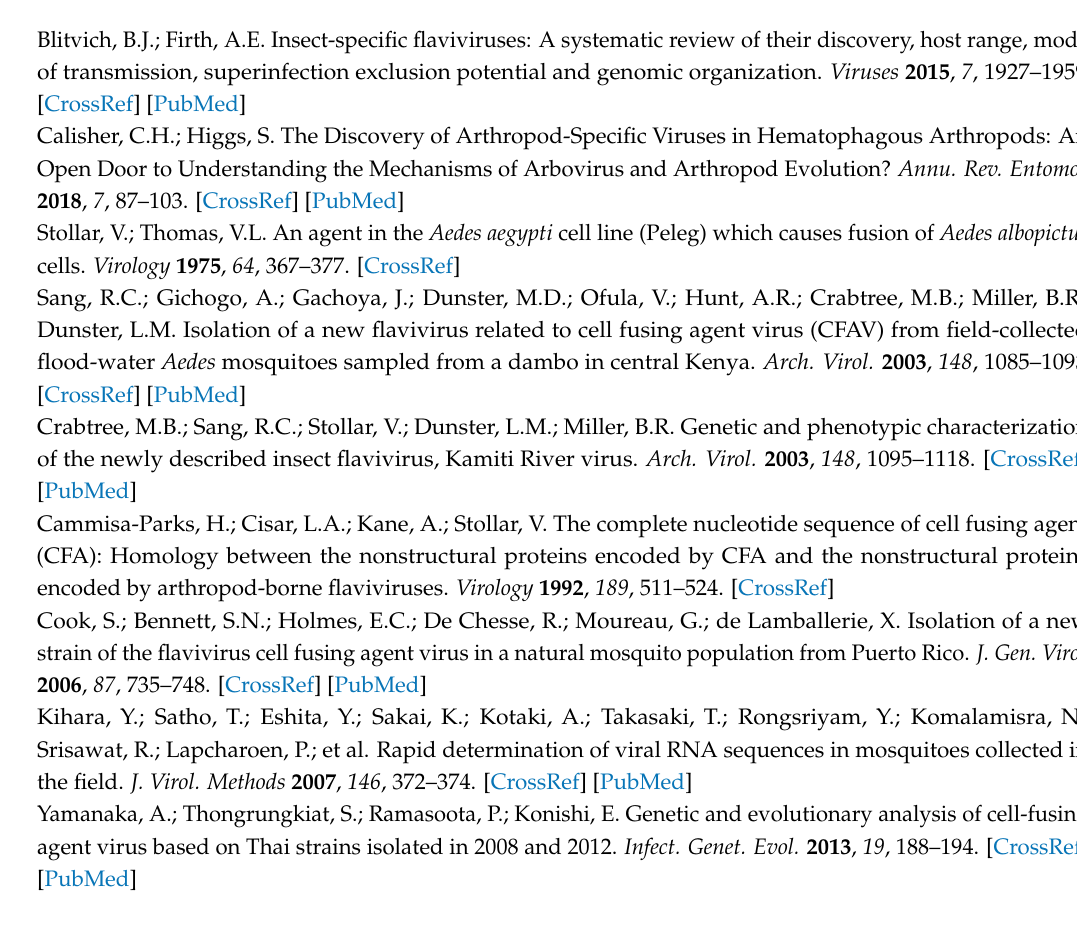
s1, Table S1: Genetic distances of the near full-length genomes of CFAV strains obtained from this study (Macap á 01 and Macap á 02) and recovered from GenBank, Table S2: Similarity (%) of the sequence of the strain Macap á 01 with sequences of flaviviruses from GenBank, Table S3: Similarity (%) of the sequence of the strain Macap á 05 with sequences of flaviviruses from GenBank, Table S4: Polyprotein differences between Macap á 01 and Macap á